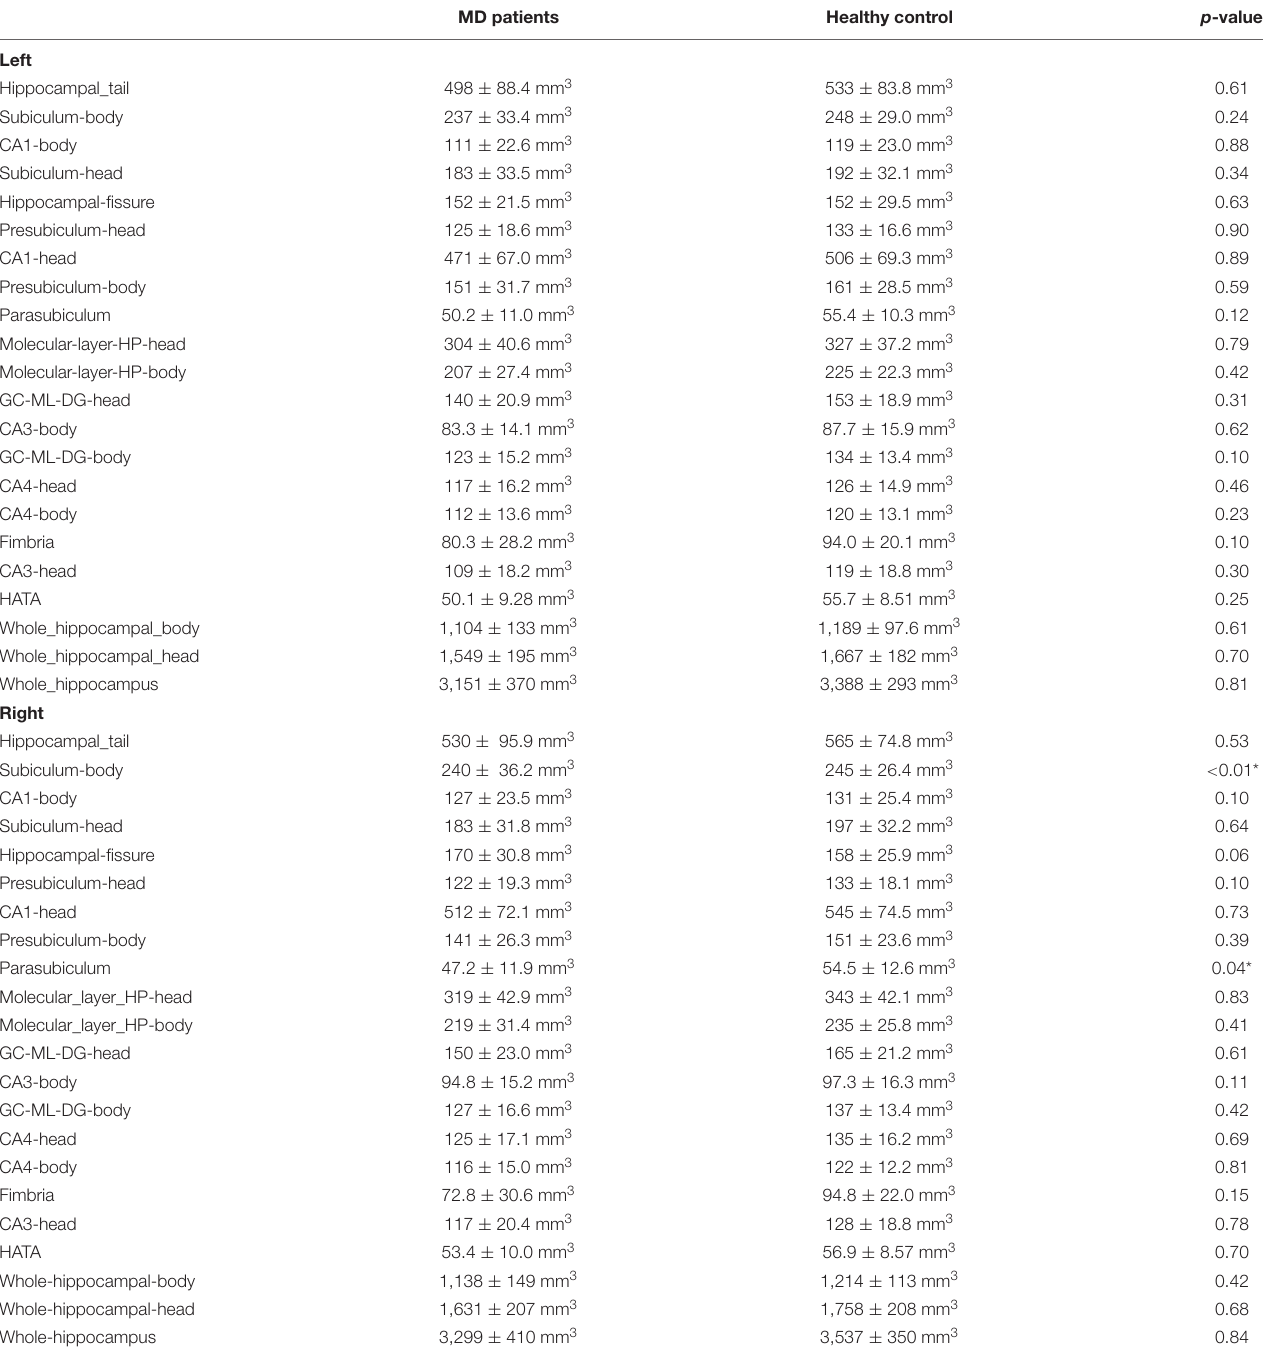
TABLE 4 | A comparison between the MD patient group and healthy control group in Hippocampal subfields. MD patients Healthy control p